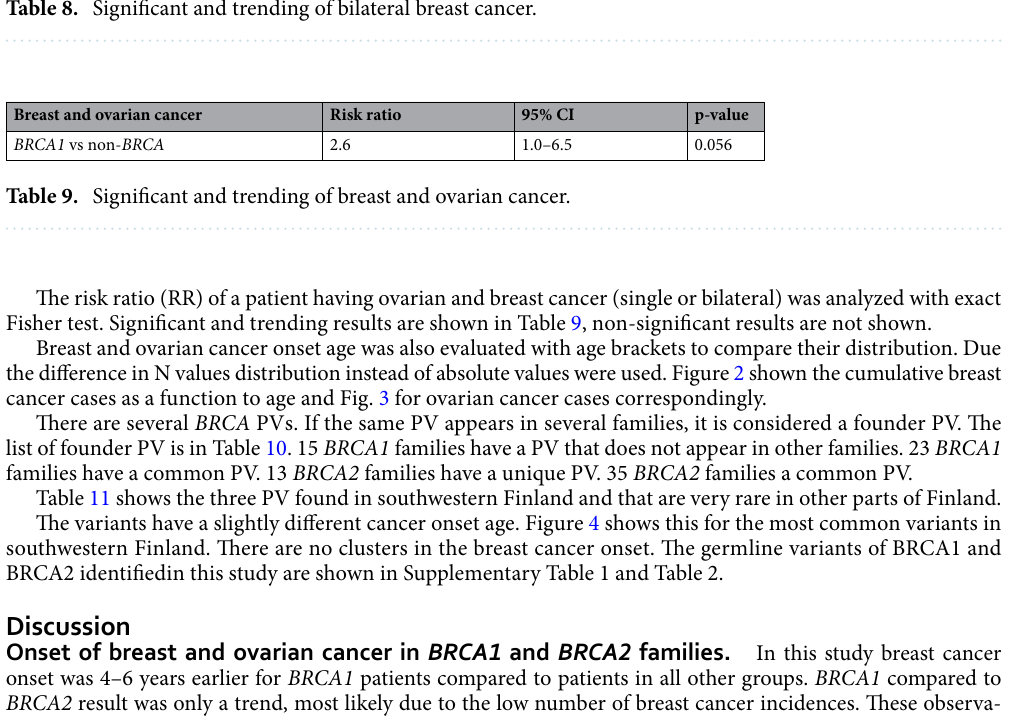
Table 8. Significant and trending of bilateral breast cancer.